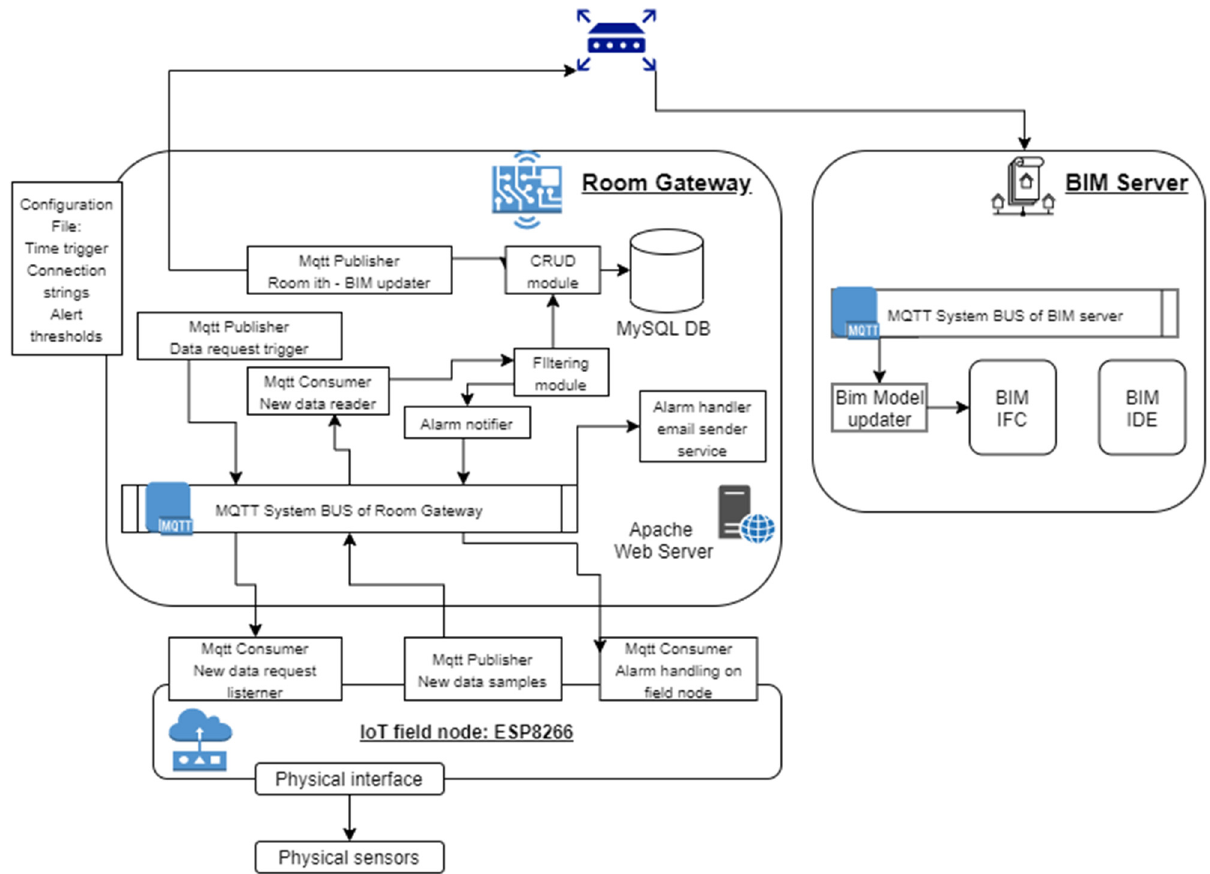
Figure 13. System architecture.